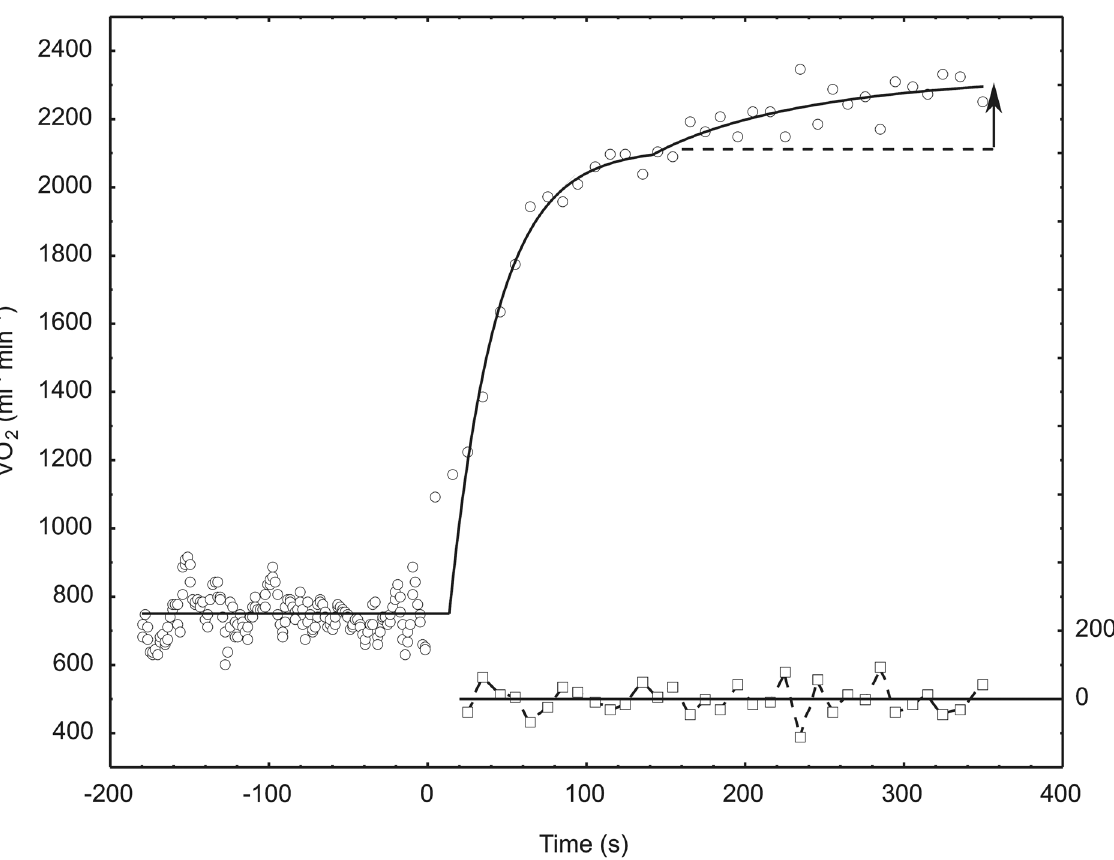
Fig 2. Models fitted to subject 3 data collected during baseline-heavy-intensity exercise transition before training and the corresponding residuals. The arrow represents the size of the slow component, which is defined as the difference between the value reached at the end of the exercise, and the value of the first (fast) exponential component (represented with the broken